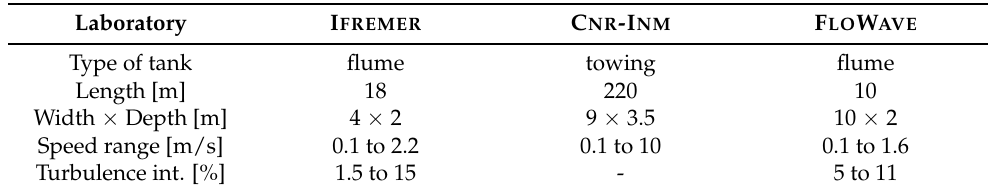
Table 2. Main characteristics of the controlled testing facilities.